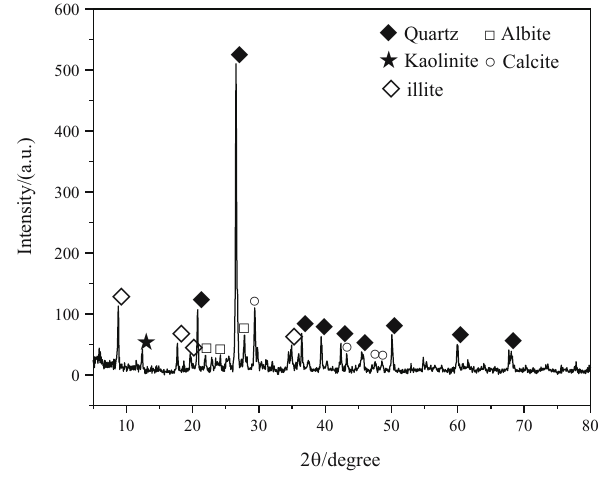
Figure 5: XRD of yellow